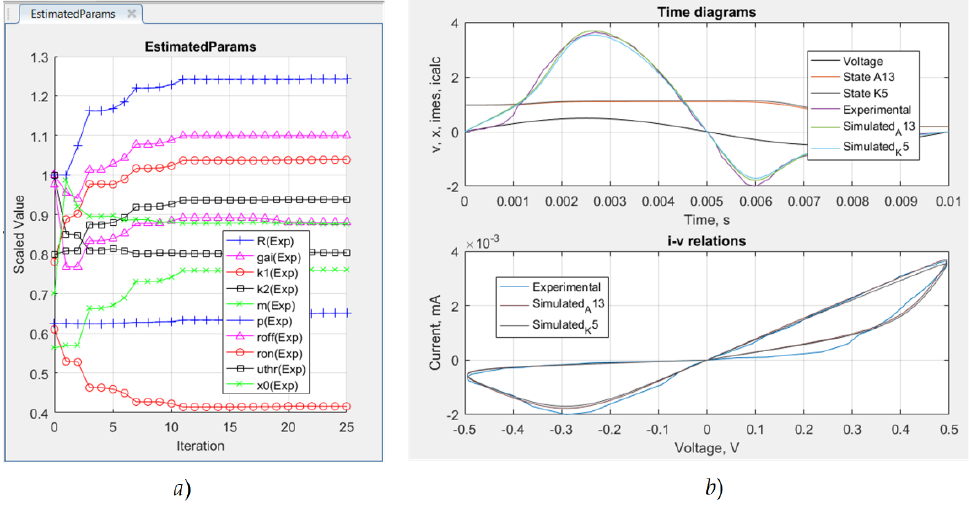
Figure 1. ( a ) Parameter trajectories obtained during the memristor model parameters estimation; ( b ) Time diagrams of the memristor voltage, experimental, and simulated currents according the modified model A 13 and the standard Lehtonen-Laiho model, denoted by K 5 , and the corresponding current–voltage relationships.